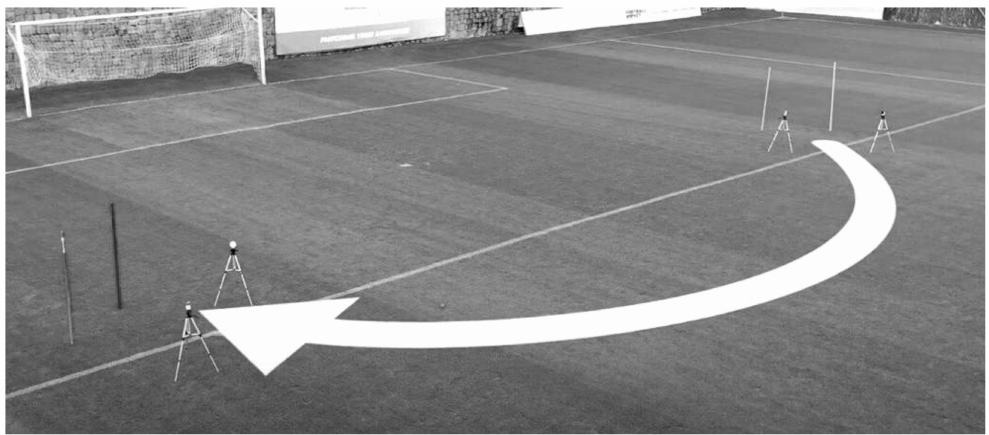
Figure 1. Schematic presentation of the curve sprint